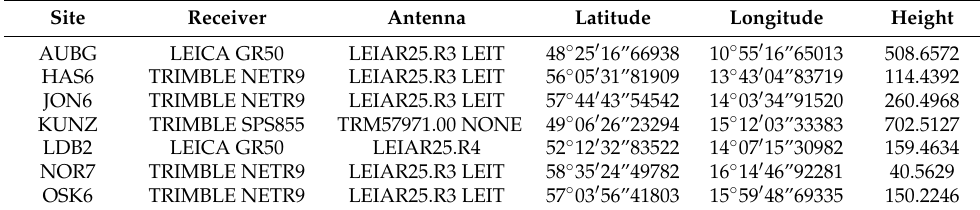
Figure 1. Geographical location of the stations. Table 1. Stations’ geographical coordinates (GRS’80).